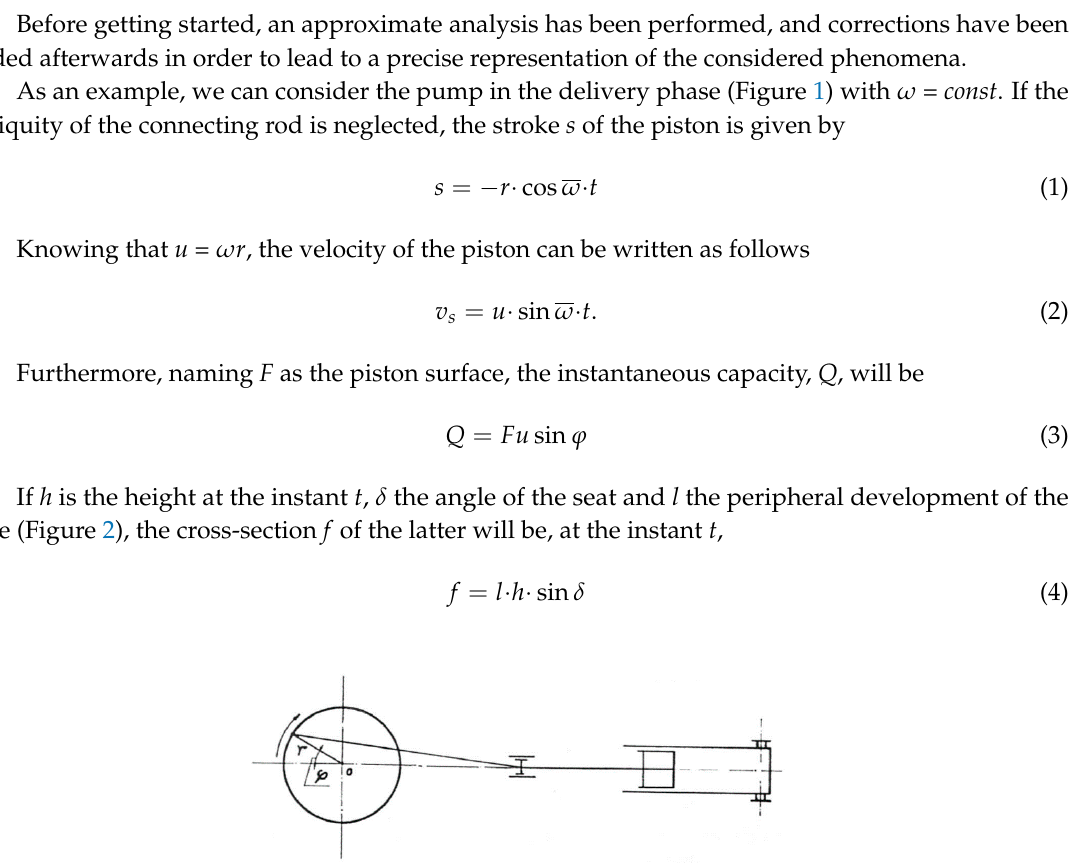
Figure 1. Pump scheme.